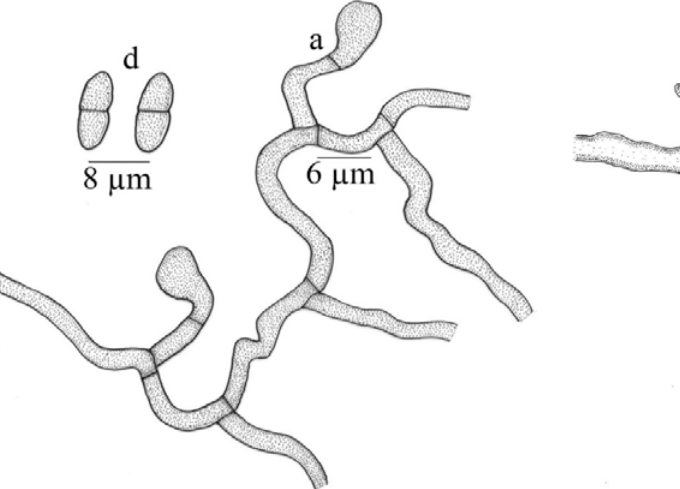
Figure 13. Armatella litseae a - Appressoriate mycelium; d -